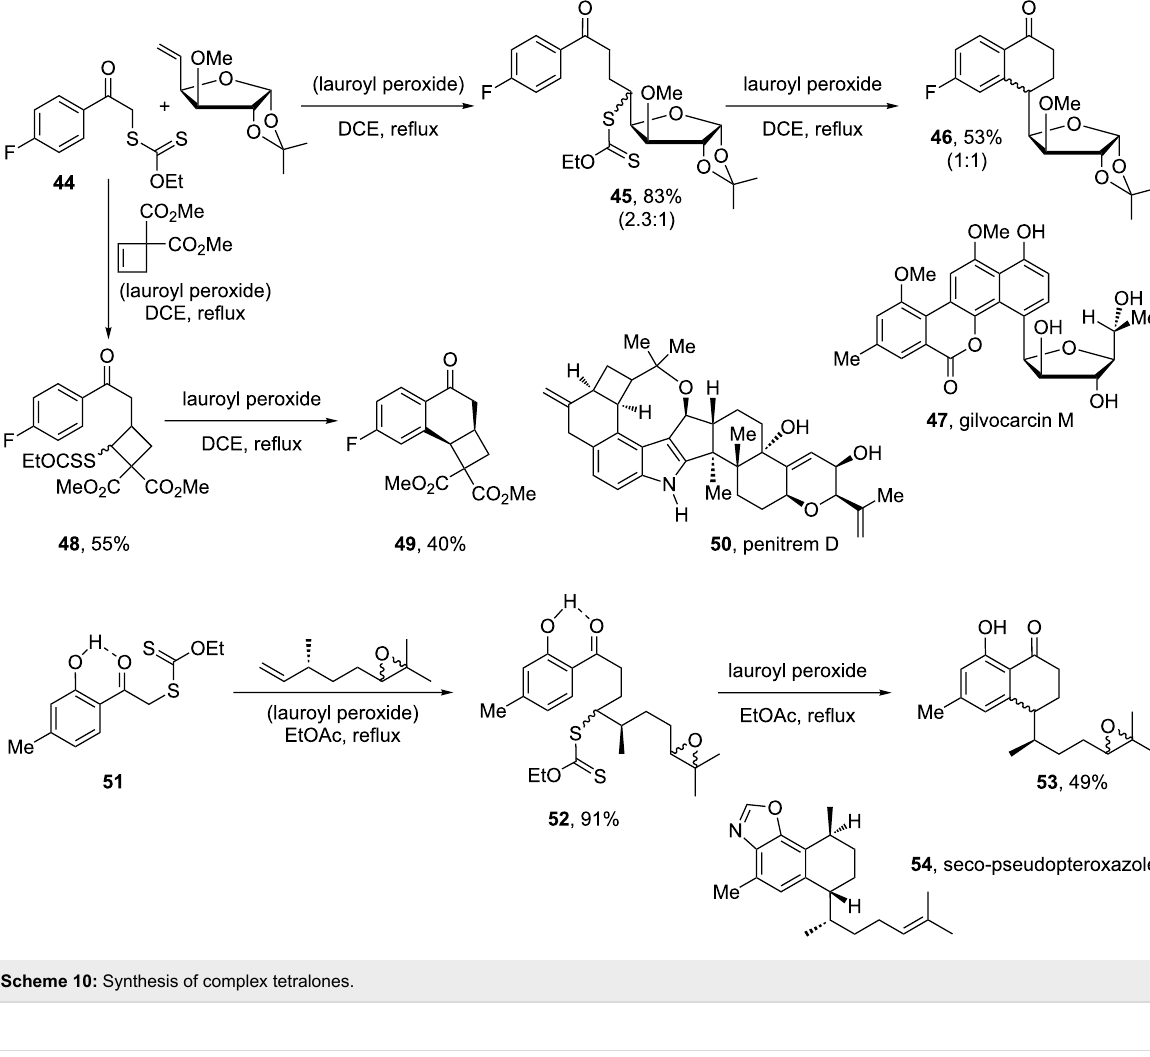
Scheme 10: Synthesis of complex tetralones.